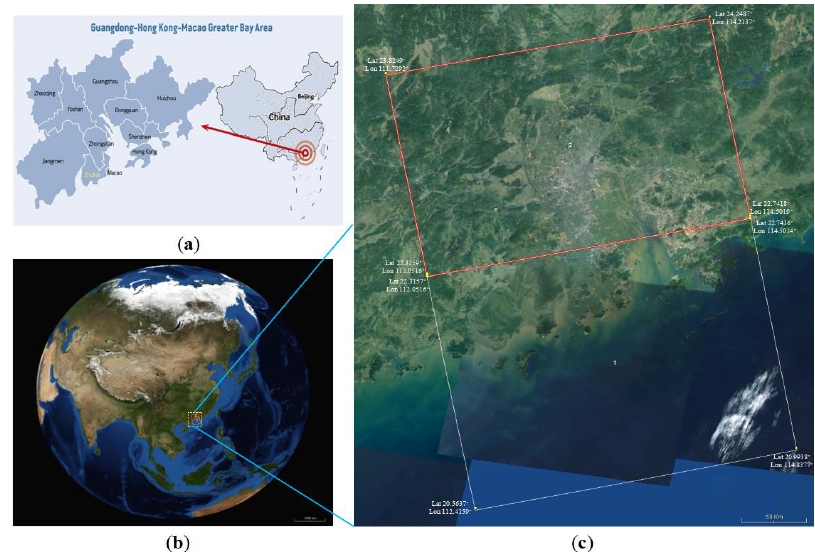
Figure 1. Some information on the study area in this paper. ( a ) The location of the Greater Bay Area in China. ( b ) The study area of the spaceborne SAR datasets on the Google Earth. ( c ) The enlarged imaging area of the two SAR datasets.